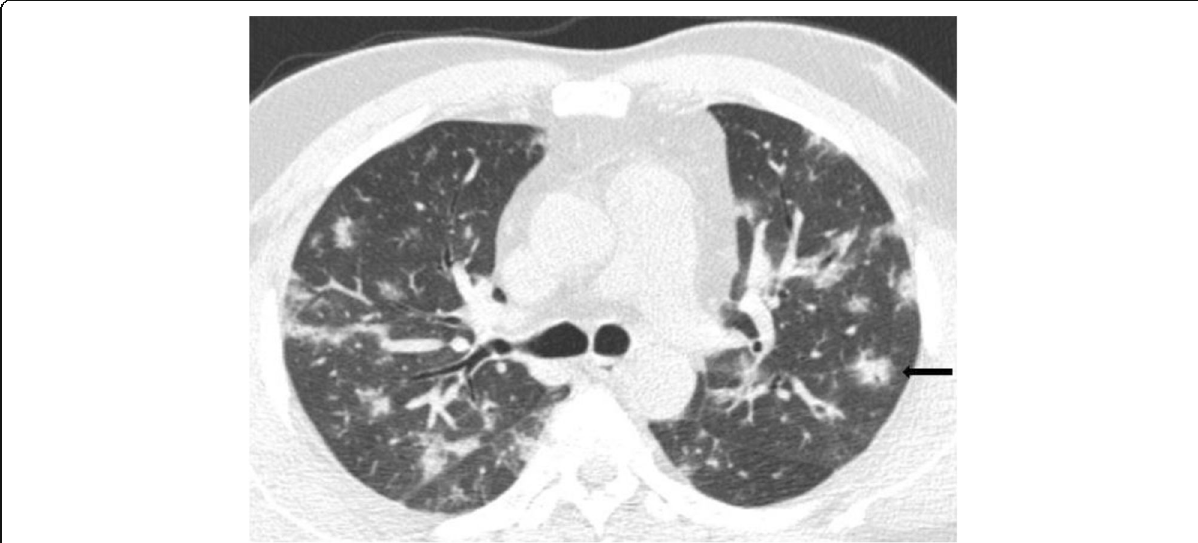
Fig. 6 Halo sign. Axial CT thorax of a 40-year-old COVID pneumonia patient showing multiple bilateral patchy consolidations with surrounding ground-glass opacities as indicated by the arrow